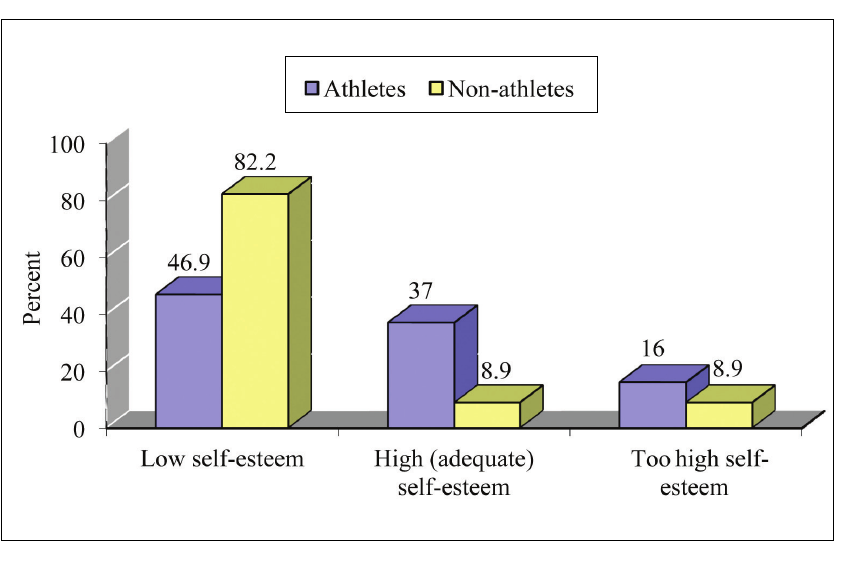
Figure 1. Self-esteem of adolescent athletes and non-athletes